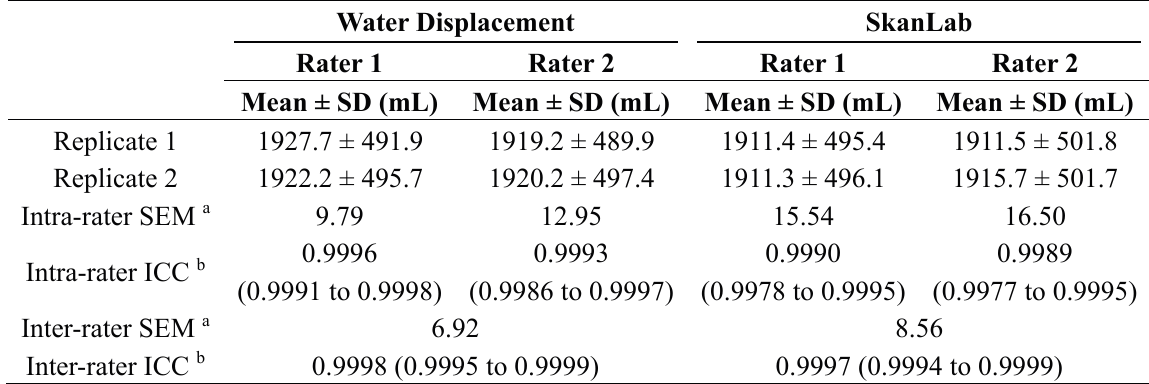
Table 6. Reliability of water displacement and SkanLab in measuring human arms (N =